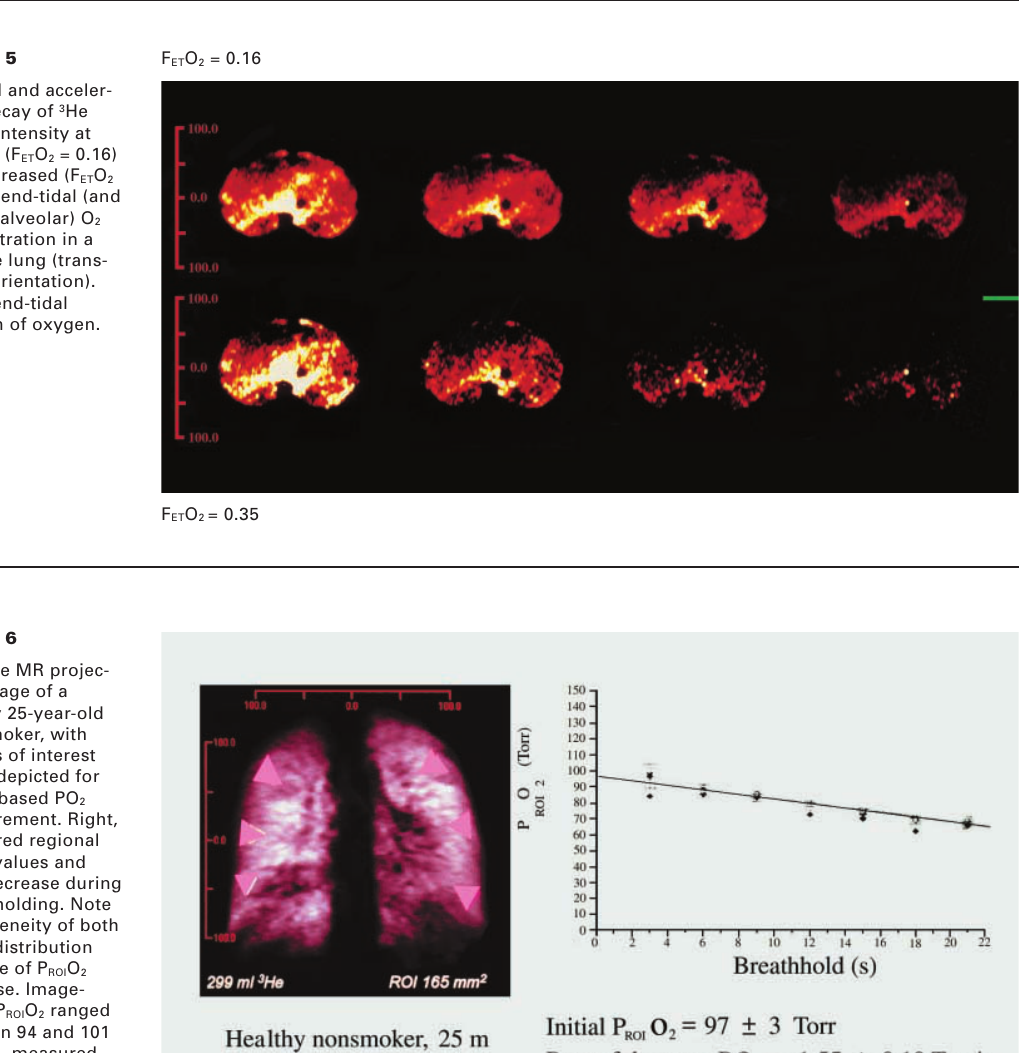
Figure 4 Diffusion-weighted 3 He MRI: Pulmonary map of the “apparent diffusion coefficient” (ADC) in a patient with IPF on the right, and a well-functioning lung graft on the left (mod. from [ 17 ] ). Note physiologically high ADC values in the tracheobronchial tree, homogeneity of ADC within the graft, as well as inhomoge- neous and sometimes pathologically in- creased ADC in the native fibrotic lung.